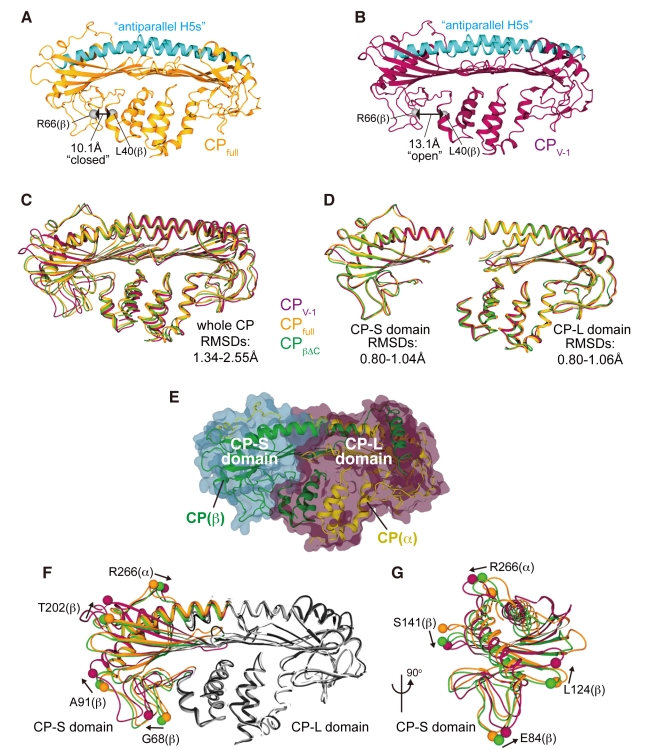
CP consists of two rigid domains and undergoes conformational changes.(A and B) Ribbon presentations of CPfull (orange) and CPV-1 (purple). The “antiparallel H5s” are highlighted in cyan and the Cα atoms of CP (β) Leu40 and Arg66 are represented as gray balls. (C) Superposition of CPfull (orange), CPβΔC (green), and CPV-1 (purple) over the Cα positions of the entire CP molecule [residues 9–275 (α) and 3–244 (β)}. (D) Superposition of the CP-L and CP-S domains. (E) Surface presentation of the CP-L (purple) and CP-S (cyan) domains. Note that the domain boundary does not correspond to the subunit interface. (F and G) Twisting of CP-S relative to CP-L. CPfull (CP-L is shown in white), CPβΔC (CP-L; gray), and CPV-1 (CP-L; black) are superimposed over CP (α) 9–257 in CP-L. Two orthogonal views are shown. To facilitate comparison, some residues are indicated as balls. In (G), CP-L was removed for clarity.